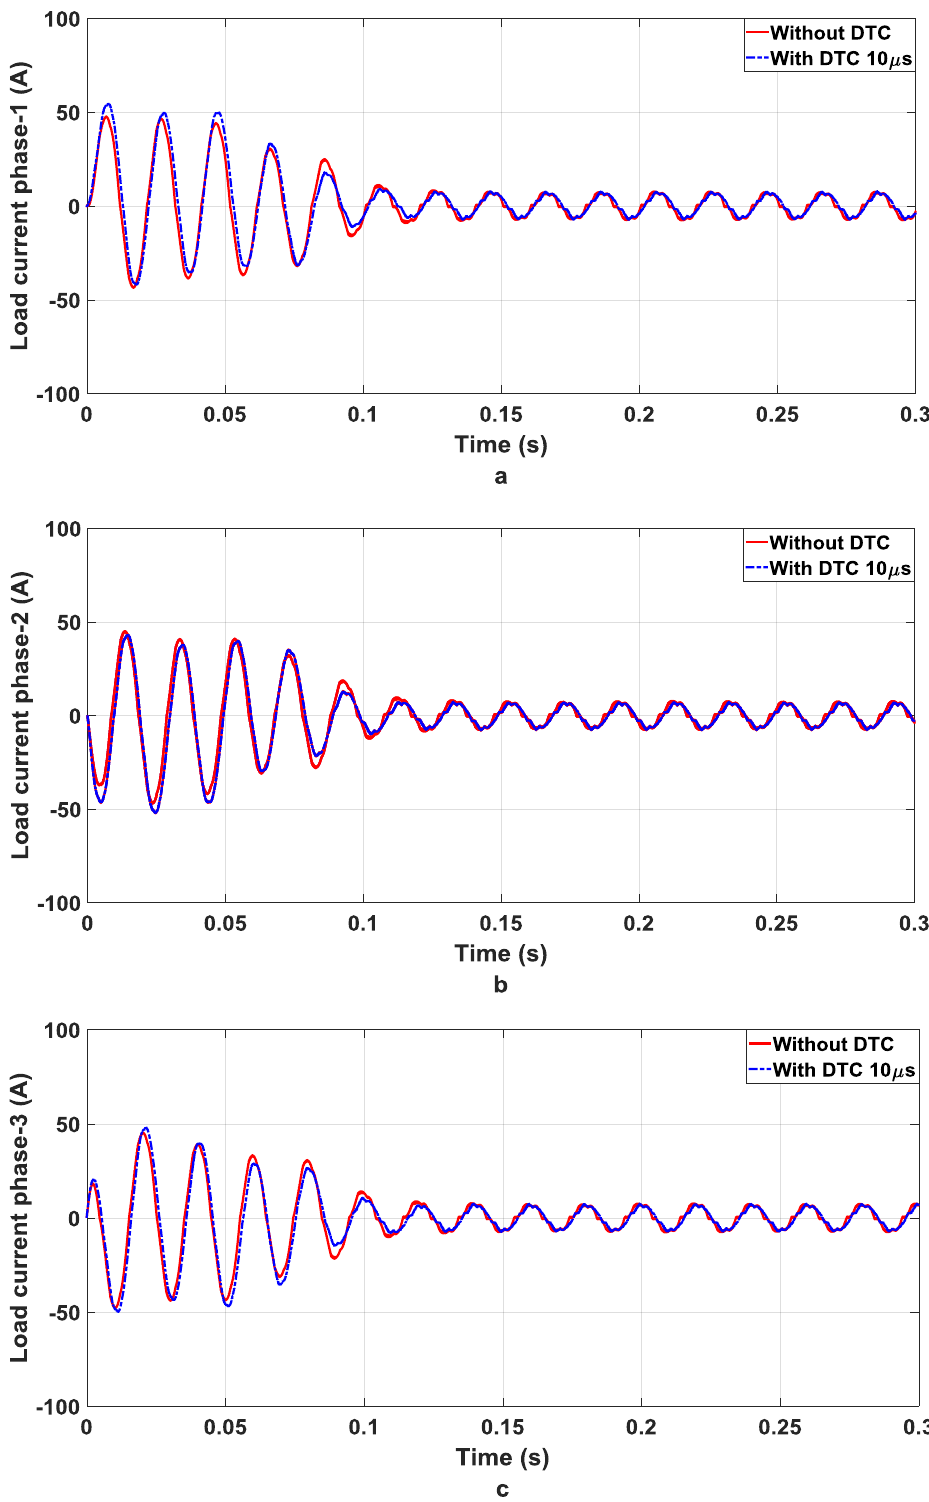
Figure 9. Load current with / without DTC ( a ) phase 1 ( b ) phase 2 ( c ) phase 3.